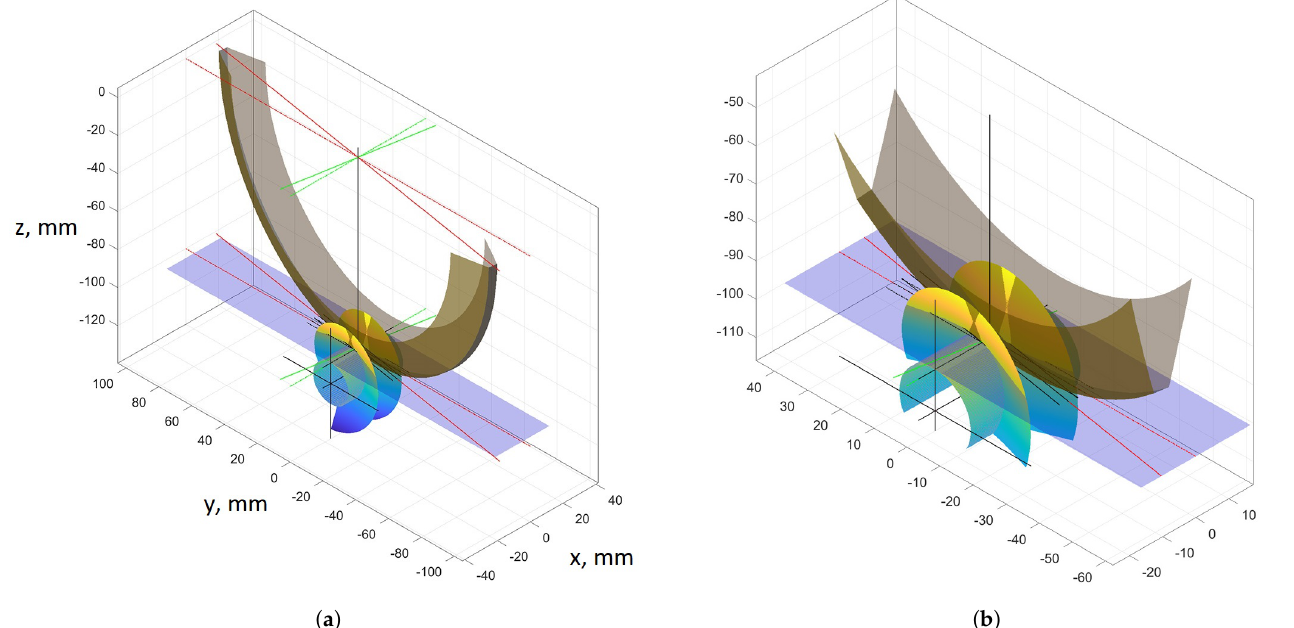
Figure 5. Shape of the grinding zone of a conical helical surface. ( a ) Image view of the zone. ( b ) Enlarged image of the